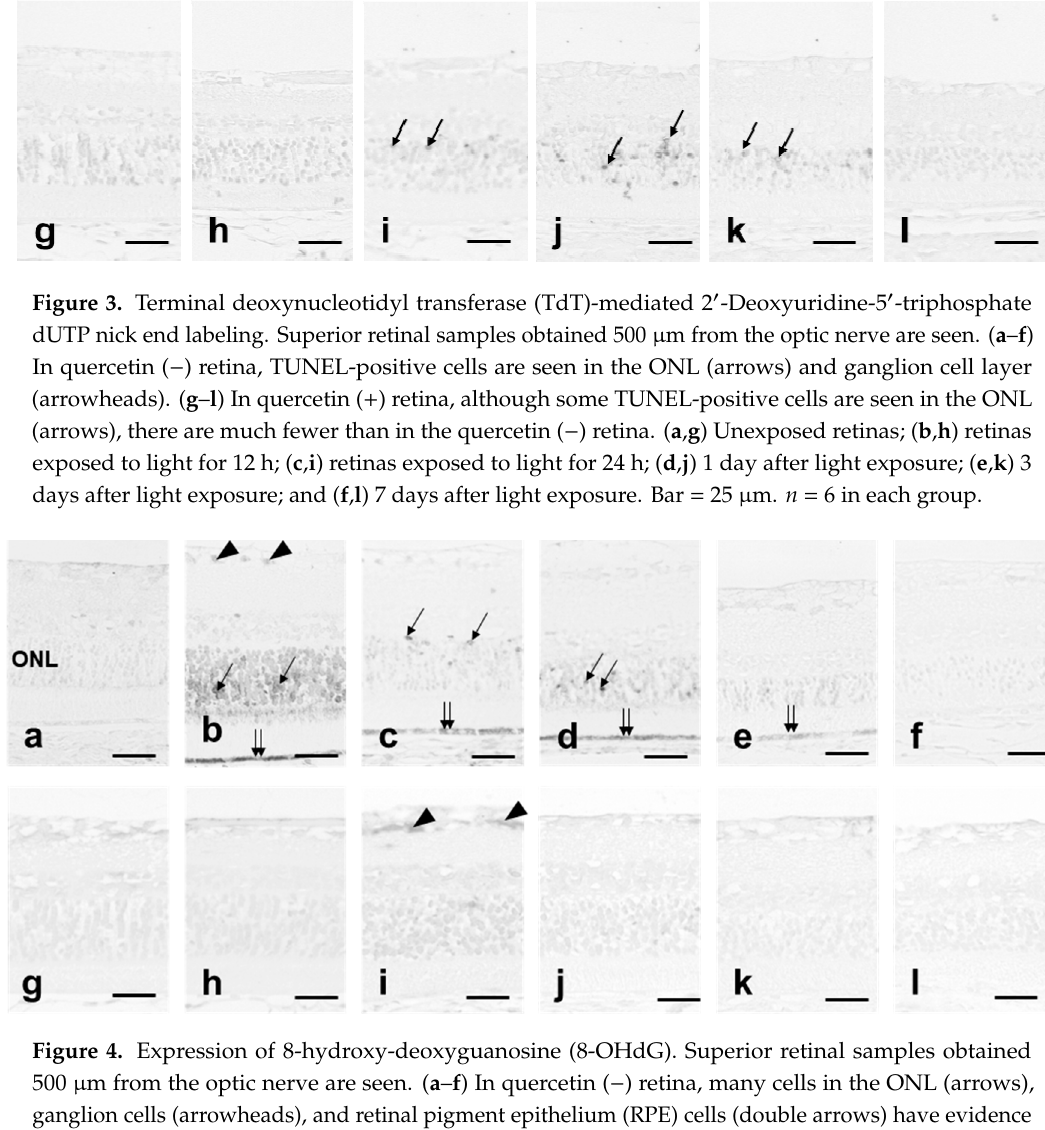
Figure 3. Terminal deoxynucleotidyl transferase (TdT)-mediated 2'-Deoxyuridine-5'-triphosphate dUTP nick end labeling. Superior retinal samples obtained 500 μ m from the optic nerve are seen. ( a – f ) In quercetin ( − ) retina, TUNEL-positive cells are seen in the ONL (arrows) and ganglion cell layer (arrowheads). ( g – l ) In quercetin (+) retina, although some TUNEL-positive cells are seen in the ONL (arrows), there are much fewer than in the quercetin ( − ) retina. ( a , g ) Unexposed retinas; ( b , h ) retinas exposed to light for 12 h; ( c , i ) retinas exposed to light for 24 h; ( d , j ) 1 day after light exposure; ( e , k ) 3 days after light exposure; and ( f , l ) 7 days after light exposure. Bar = 25 μ m. n = 6 in each group.